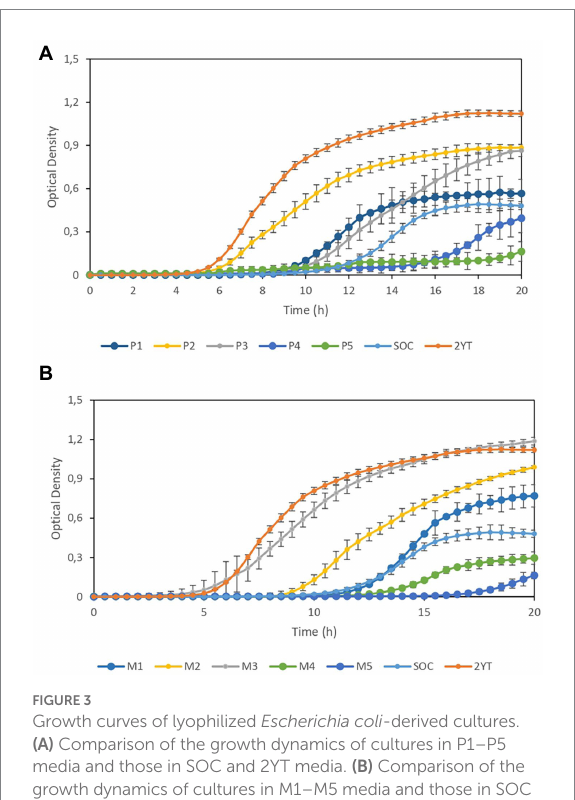
FIGURE 3 Growth curves of lyophilized Escherichia coli -derived cultures. (A) Comparison of the growth dynamics of cultures in P1–P5 media and those in SOC and 2YT media. (B) Comparison of the growth dynamics of cultures in M1–M5 media and those in SOC and 2YT media. Error bars are the standard deviation of three independent